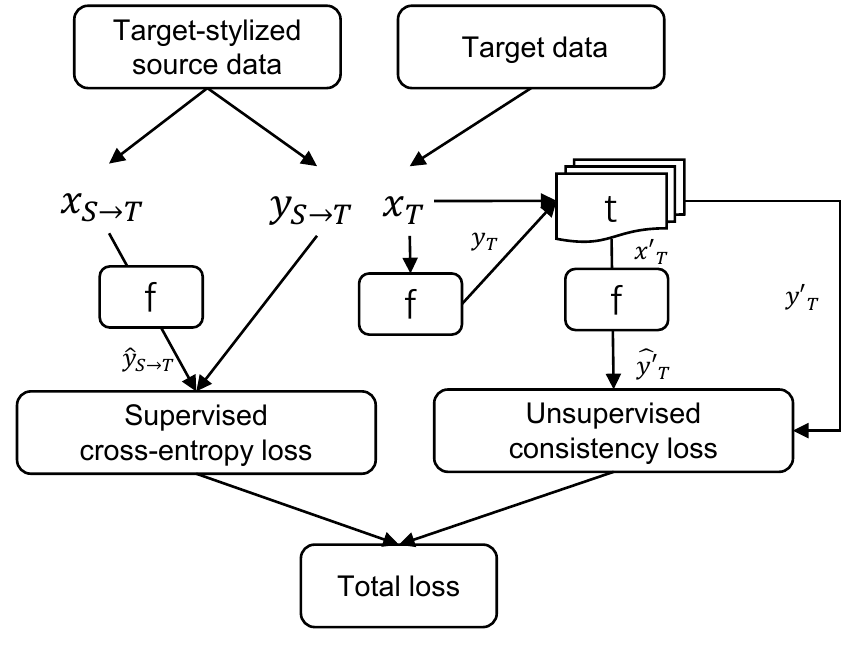
Figure 3. Flowchart of self-supervised consistency training: x S → T and y S → T are target-stylized source image and label; x T and y T are target image and pseudolabel. f denotes the pixelwise mapping from images to semantic output; t is the transformation function; x (cid:48) target image and pseudolabel; ˆ y S → T and ˆ y (cid:48)